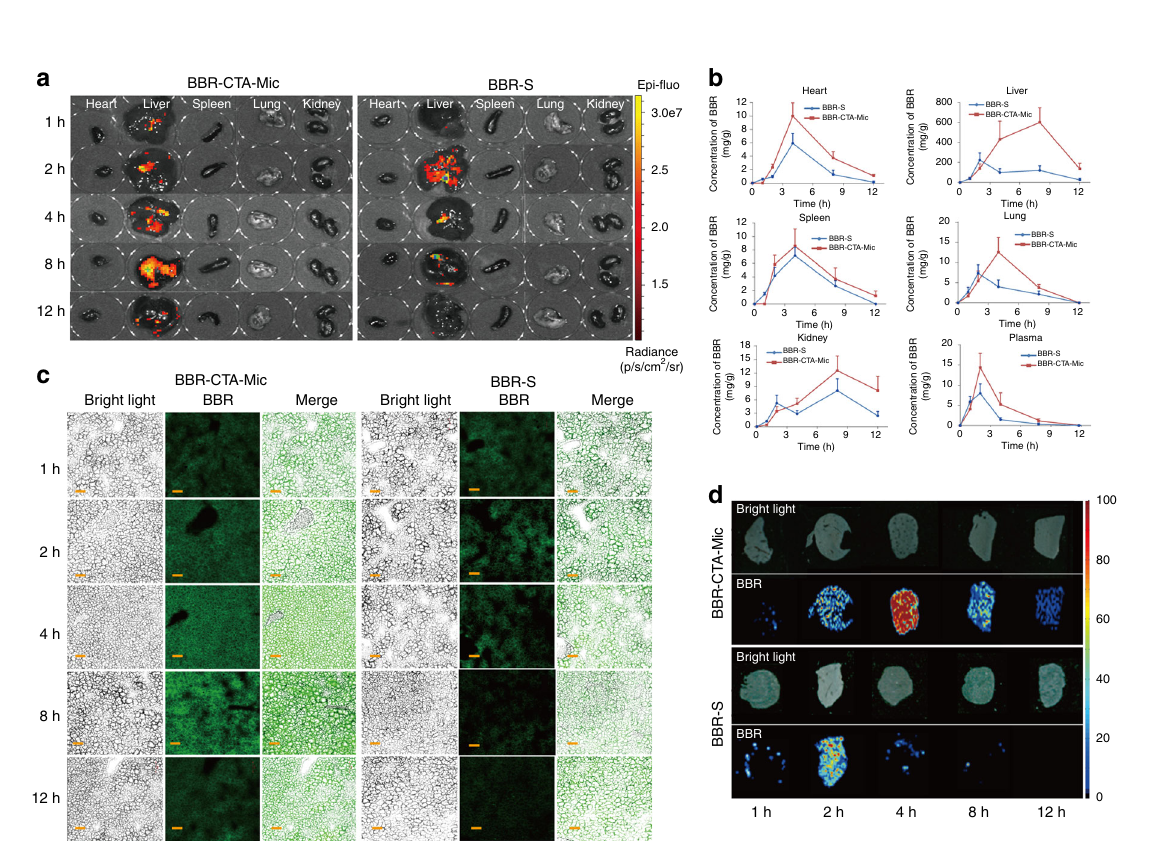
Fig. 3 Bio-distribution Evaluation. C57BL/6J mice were administered with BBR-S or BBR-CTA-Mic (50 mg kg − 1 of BBR) via gavage injection. a At each predetermined time point, a group of fi ve mice for each formulation were euthanized and blood (0.5 mL) were obtained from posterior orbital venous plexus to a heparinized tube and major organs (heart, liver, spleen, lung, and kidney) were harvested. Major organs were imaged using the IVIS imaging system at excitation/emissio n = 465/540 nm. (Heart, liver, spleen, lung, and kidney, from left to right). b Quantitative analysis of the distribution of BBR in C57BL/6J mice at different time points achieved via LC/MS/MS. ( n = 5, mean ± SEM). Liver-focused evaluation was applied to further assay the hepatic cell accumulation of BBR in BBR-S or BBR-CTA-Mic group. The cryostat sections of liver sample were prepared by cutting the liver tissue into 4 μ m. c Liver cell accumulation of BBR was visualized using CLSM LSM710 (Carl Zeiss, Germany) Ex = 365 nm; Em = 480 nm. d Liver accumulation of BBR was tested using ambient mass spectrometry imaging method. The experiments were performed on an air- fl ow-assisted desorption electrospray ionization (AFADESI)-MSI platform equipped with a Q-Orbitrap mass spectrometer. Scale bars, 50 μ m ( c